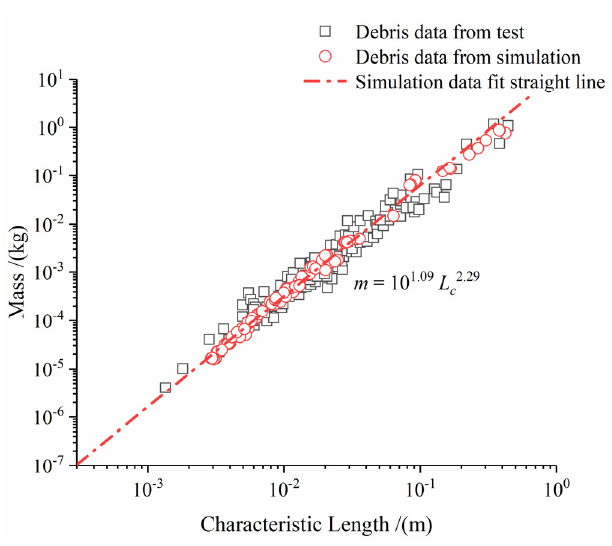
Figure 30. Comparison of fragment characteristic length–mass relationship between simulation and test.